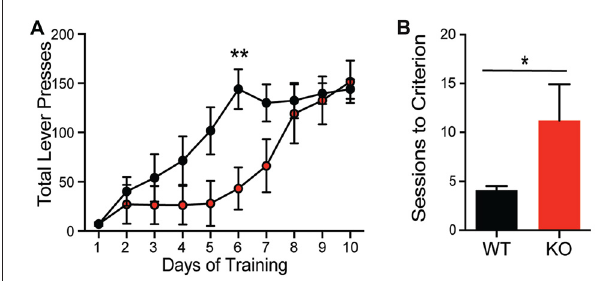
FIGURE 4 | Shank2 mutation results in impaired acquisition of operant behavior. Shank2 KOs require more training to acquire both the operant lever press task (A) and a location discrimination touchscreen task (B) . In all panels WT animals are in black and KO animals are in red. Bars indicate